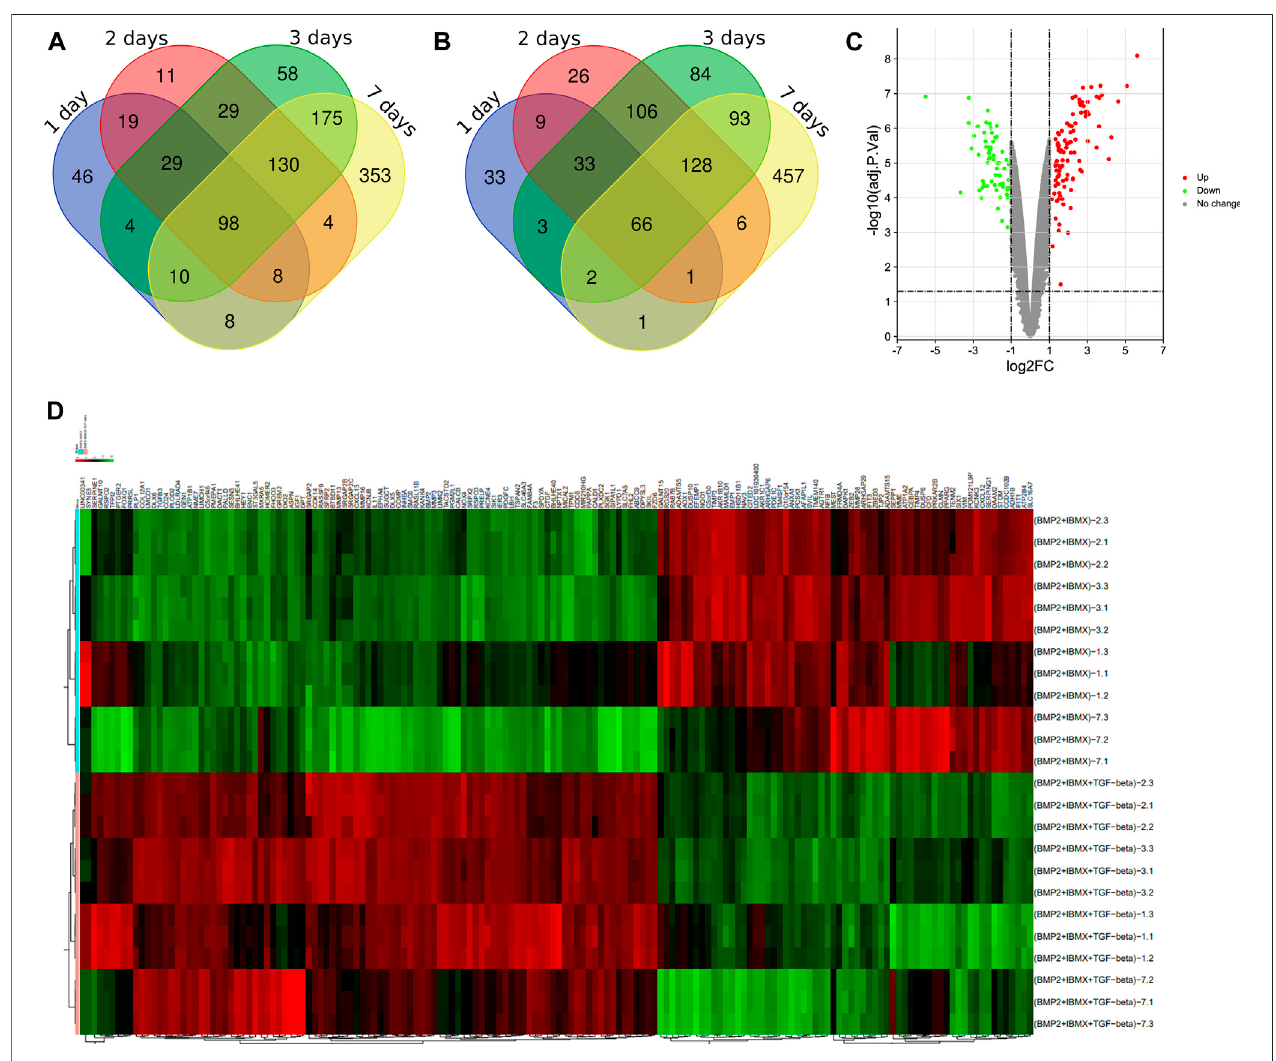
FIGURE2| Venndiagramsshowing (A) the98upregulatedgenesand (B) the66downregulatedgenes.Adifferentiallyexpressedgene(DEG)volcanoplot (C) and a heatmap (D) are shown. Red represents upregulated genes, and green represents downregulated genes ( p < 0.05, logFC ≥ 1 or logFC ≤ − 1).